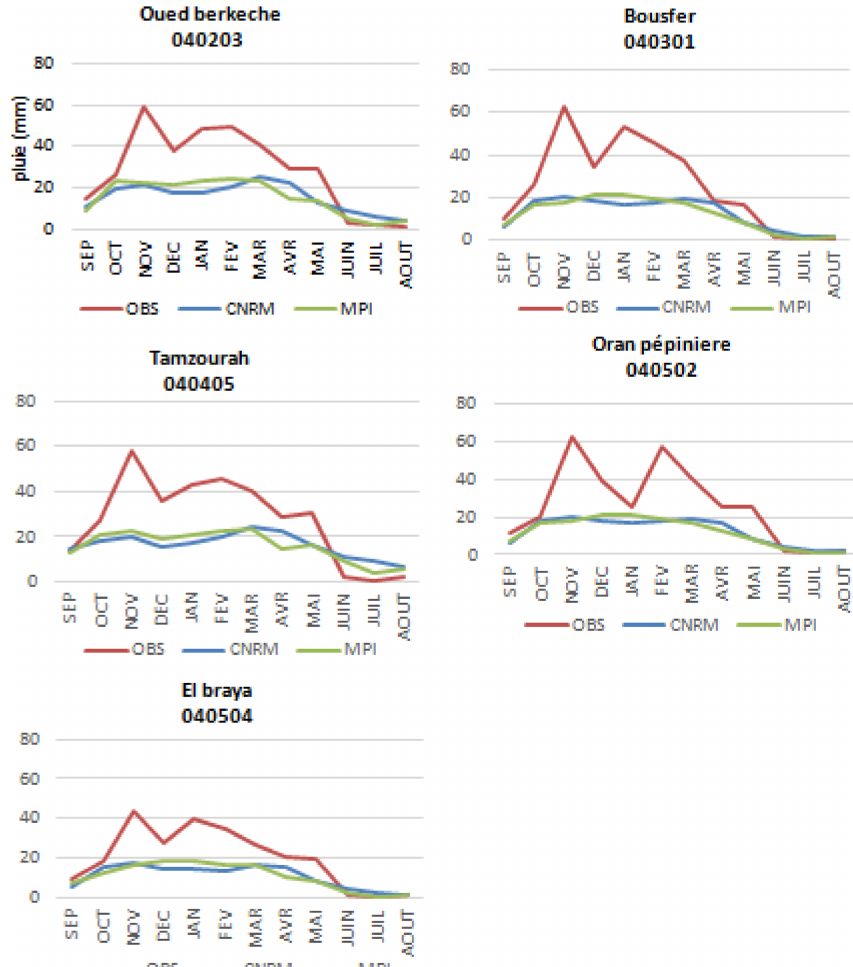
Figure 2. Représentation du cycle saisonnier par les MCR pour chaque